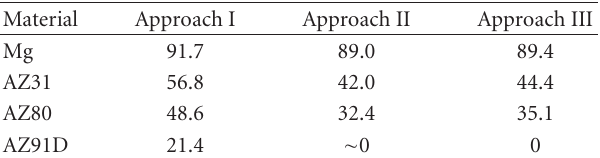
Table 5: Relative importance of the anomalous response e ff ect. AR percentages estimated on the assumption of Approaches I, II, and